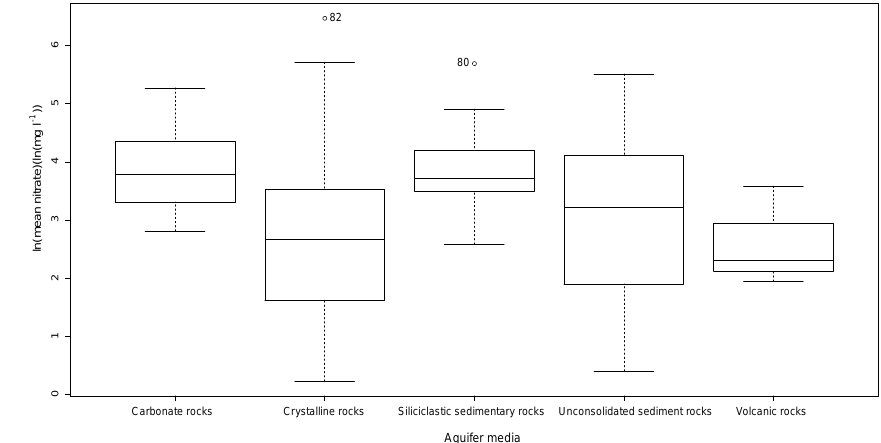
Figure 7. Log transformed mean nitrate concentration for different aquifer system